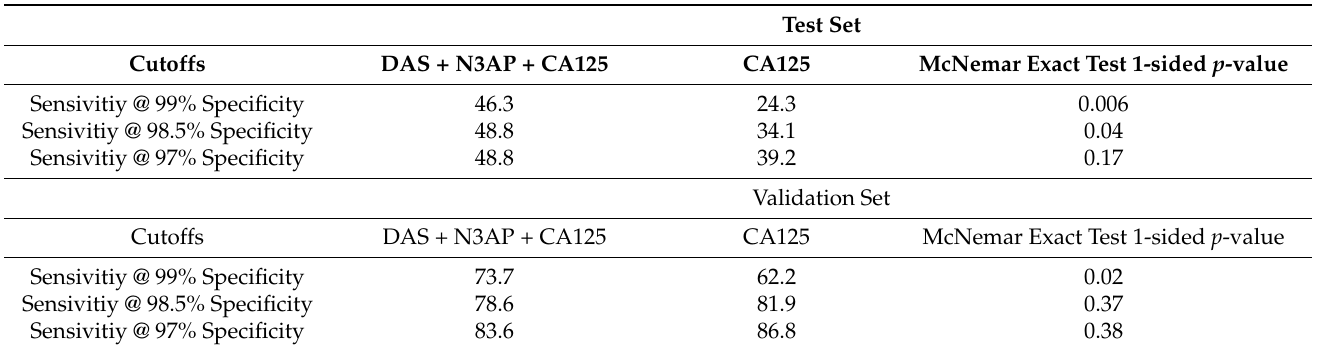
Table A6. Sensitivity of the 3-marker panel and CA125 alone at specificity cutoff values of 99%, 98.5% and 97% in the Test Set and Validation Set.